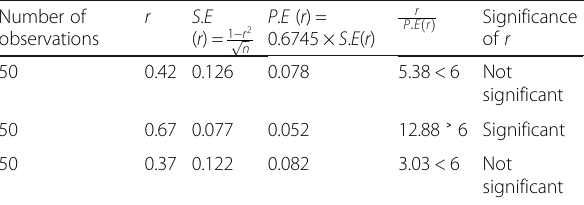
Table 4 Significance of correlation between Thumb, Index, and Ring finger per unit length for periphery position